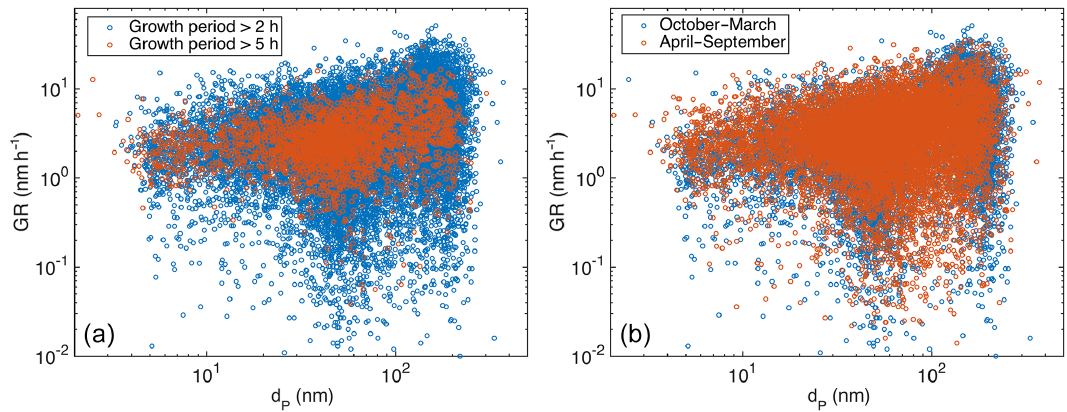
Figure 4. Observed particle growth rate as a function of the initial size of the growing mode, in panel (a) separated with the length of the observed growth period and in panel (b) with the time of the